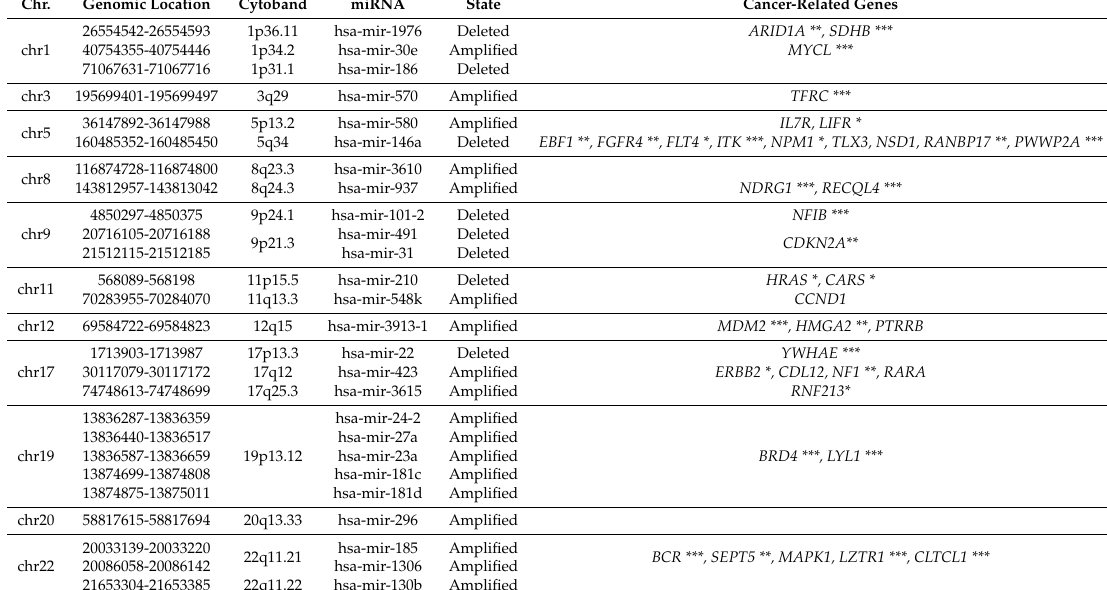
Table 1. SCNA-miRNA regions and exactly matched pan-cancer SCNA regions with cancer-related genes. (The degree of correlation between miRNAs and cancer-related genes is marked with asterisks: * (0.1–0.2), ** (0.2–0.3), *** (>0.3) in at least one cancer type).